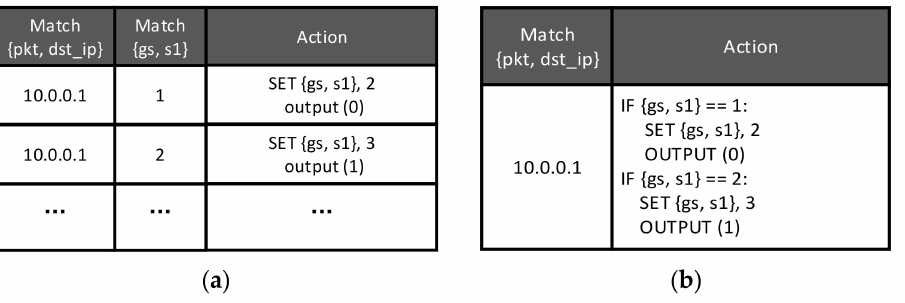
Figure 8. Implement state transitions through match–action table. ( a ) Compare state with matching field; ( b ) Compare state with